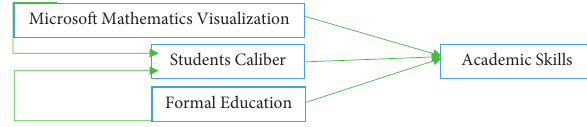
Figure 1: Framework of